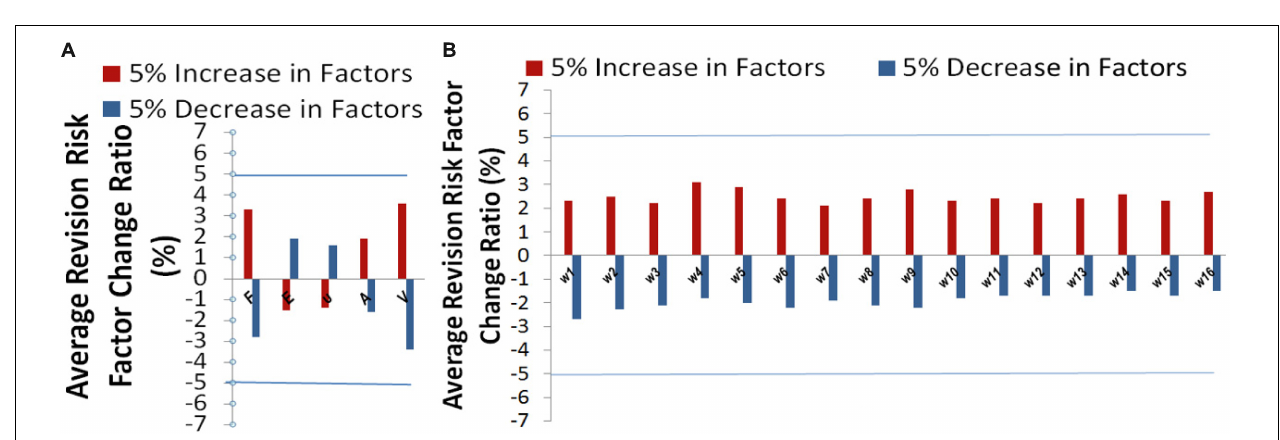
FIGURE 5 | Stress distribution in aortic tissue.